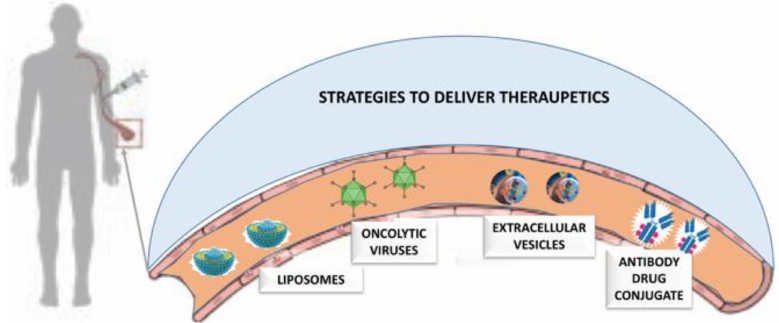
Figure 2. Innovative drug delivery